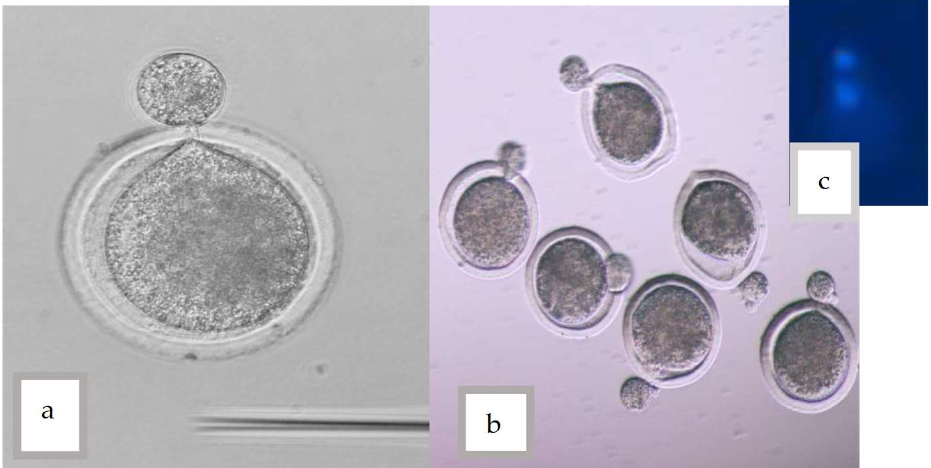
Figure 1. ( a , b ) A small amount of cytoplasm was pushed out from the ZP ( c ) Confirmation of enucleation using Hoechst stain and UV light.